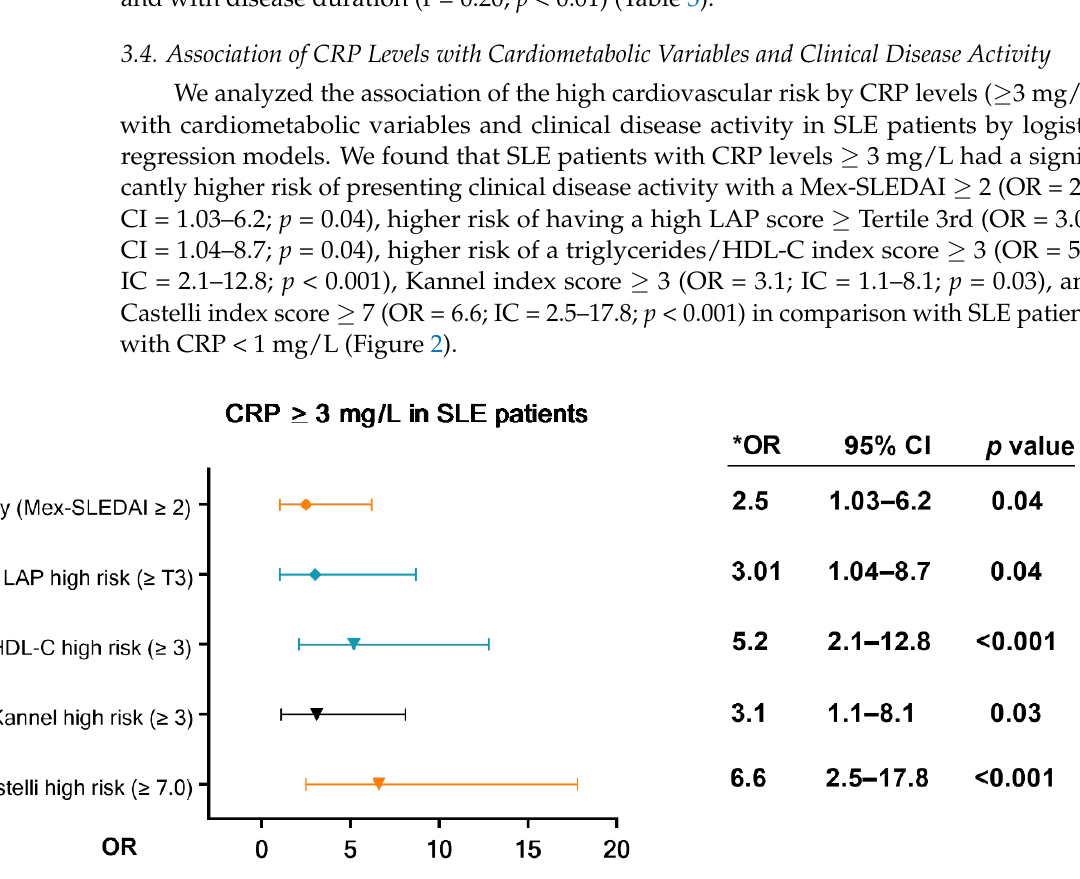
Figure 2. Association of the CRP levels ( ≥ 3 mg/L) with clinical activity and cardiometabolic variables in SLE. Castelli index: total cholesterol/HDL-C; Kannel index: LDL-C/HDL-C ratio; LAP score: (waist circumference, cm–58) (TG, mmol/L). T3: ≥ 31.06 to maximum value; OR: odds ratio, confidence interval 95%, p values < 0.05. * Reference group: SLE patients with CRP < 1 mg/L.